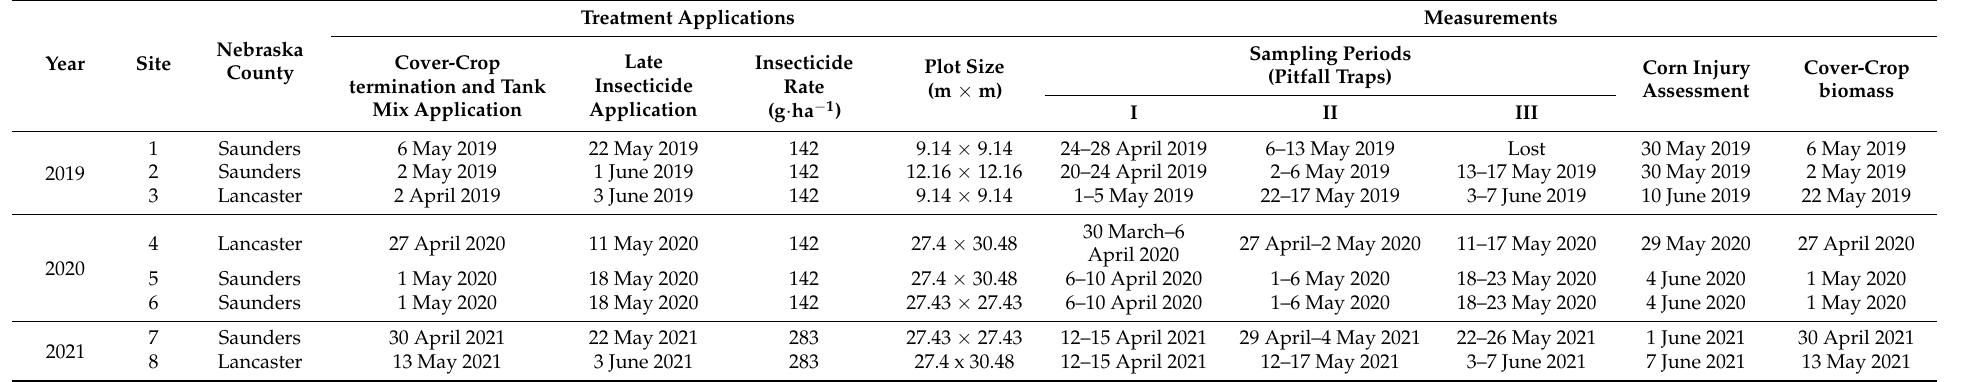
Table 2. Treatment application dates, details, and measurement information per site and